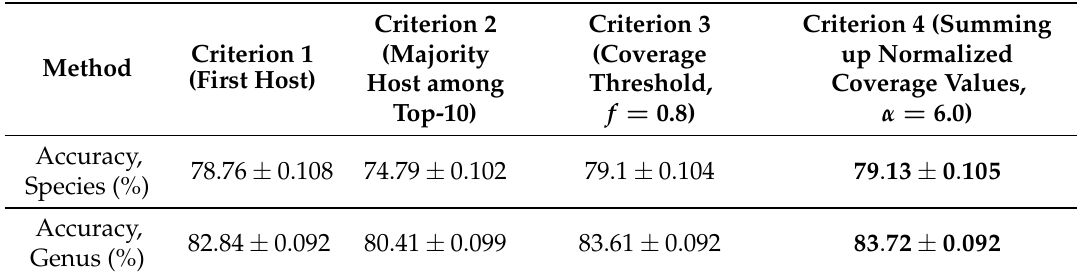
Table 2. Average and mean standard error of the overall HostPhinder performance over 100 phages set resamplings with train-test